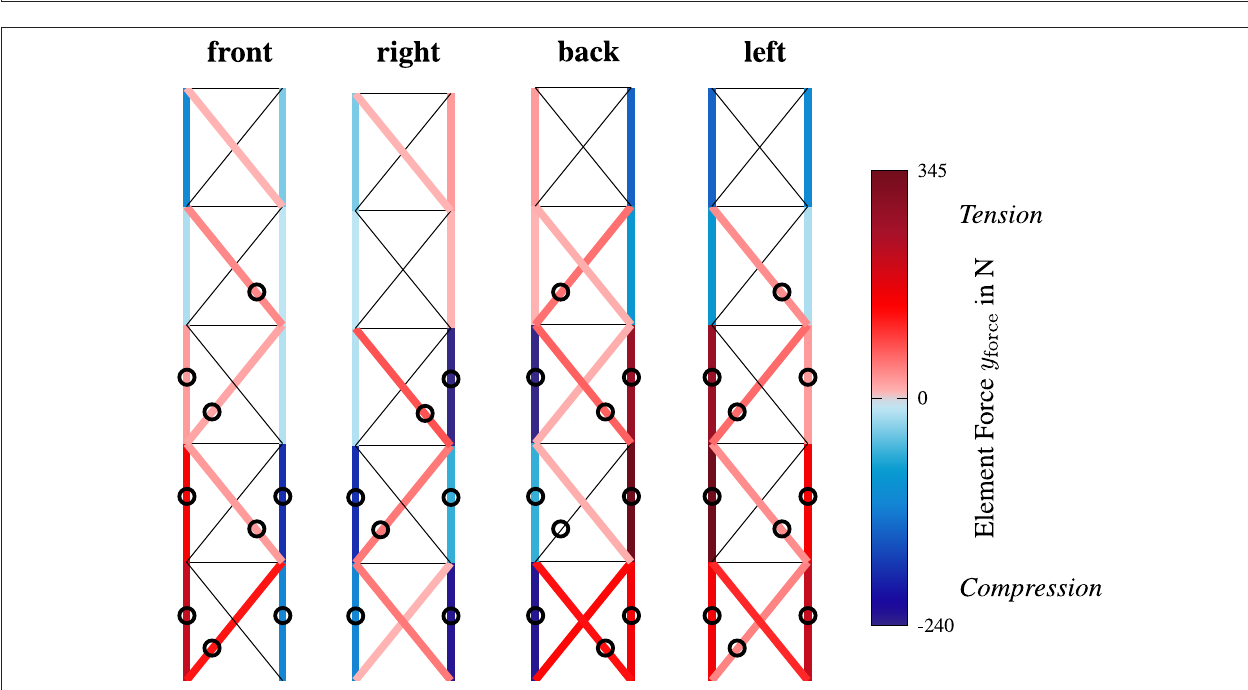
FIGURE 9 | Measured element forces for the structure under load and without compensation, as in Figure 5B . Tension is indicated in red and compression in blue. Actuated elements are marked with a circle. The title indicates the viewing direction.